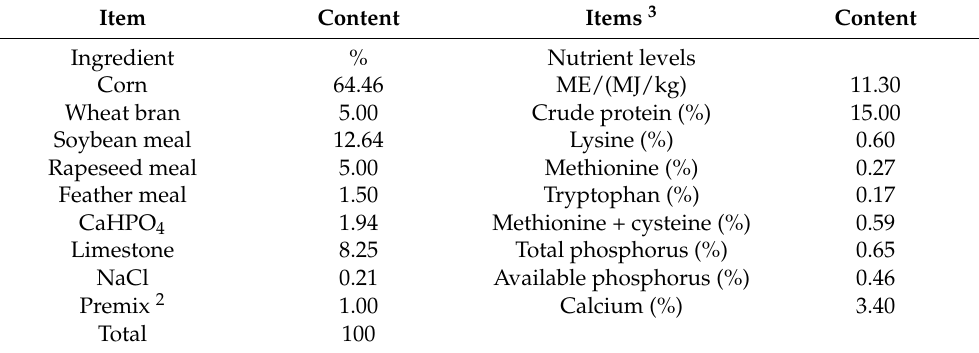
Table 1. Dietary composition and nutrient levels of the basal diet for the Danzhou chickens 1